Question: Write a caption explaining this figure to a reader.
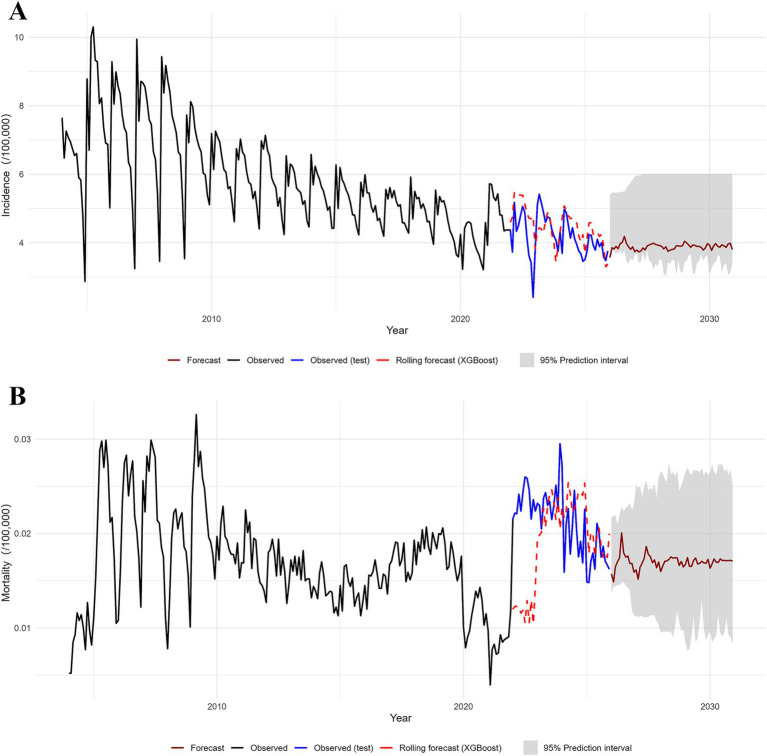
Answer: Forecasted trends of PTB incidence and mortality in China based on rolling-window validation and final projections to 2030. (A) Incidence: forecasts generated by the XGBoost model using quantile regression (50th percentile as a point forecast and 2.5th and 97.5th percentiles for 95% prediction intervals). The model was evaluated using an expanding rolling-window scheme (training windows from 2004–2021 to 2004–2024) to produce one-year-ahead forecasts for 2022–2025 (rolling forecast), and then refitted to the full dataset (2004–2025) to project monthly incidence from 2026 to 2030. Hyperparameters: eta = 0.1, max_depth = 5, subsample = 0.8, colsample_bytree = 0.8, min_child_weight = 3. Observed: historical observed values (2004–2021). Observed (test): actual observed values during the test period (2022–2025). Rolling forecast: rolling forecast values (one-year-ahead predictions for 2022–2025). Forecast: final forecast values (2026–2030). Shaded area: 95% prediction interval (from XGBoost quantile regression). (B) Mortality: forecasts generated by the XGBoost model using quantile regression (same settings as for incidence). The same rolling-window evaluation was applied, and the final model was refitted to the full dataset to produce projections for 2026–2030 with 95% prediction intervals. Observed: historical observed values (2004–2021). Observed (test): actual observed values during the test period (2022–2025). Rolling forecast: rolling forecast values (one-year-ahead predictions for 2022–2025). Forecast: final forecast values (2026–2030). Shaded area: 95% prediction interval (from XGBoost quantile regression).